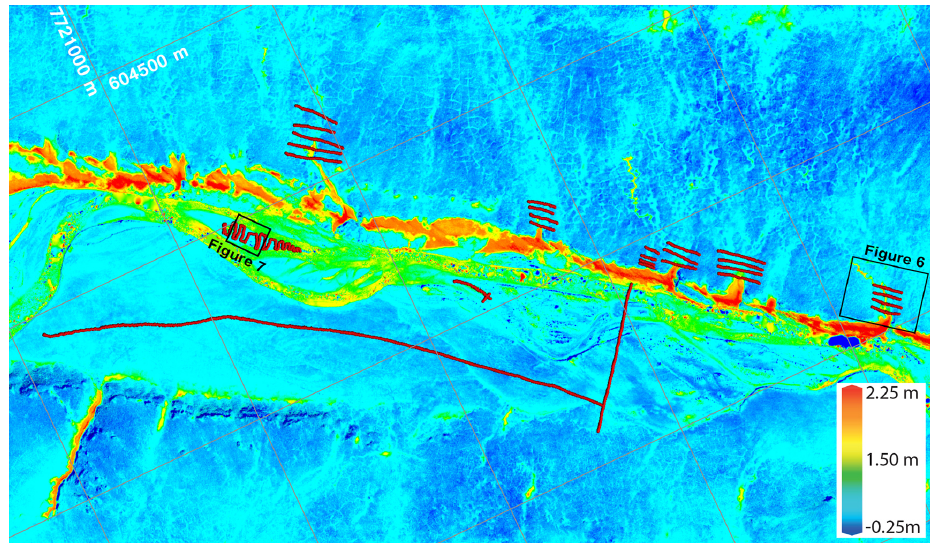
Figure 5. This top-view difference map of the Hulahula River valley (20 April 2014 minus 13 June 2014) contains the oblique region shown in Fig. 1. It reveals a complex snow distribution, with areas free of snow, snow filling individual ice wedges in polygonal ground, and gullies filled with snow, as well as large drifts over 3m thick along the bluffs of the river. The river, flowing from left to right, northbound to the Arctic Ocean (green areas) introduces larger errors, as described in the text, because the summer surface is water. The red points overlaid are from snow probing. Inset boxes show the locations of Fig. 6 (gully transects at right) and Fig. 7 (island points at left). UTM 6N graticule is overlaid at 500m spacing. The majority of negative values appear at the edges of bluffs and gullies at lower left, and are likely caused by the compression of shrubs by the snow pack